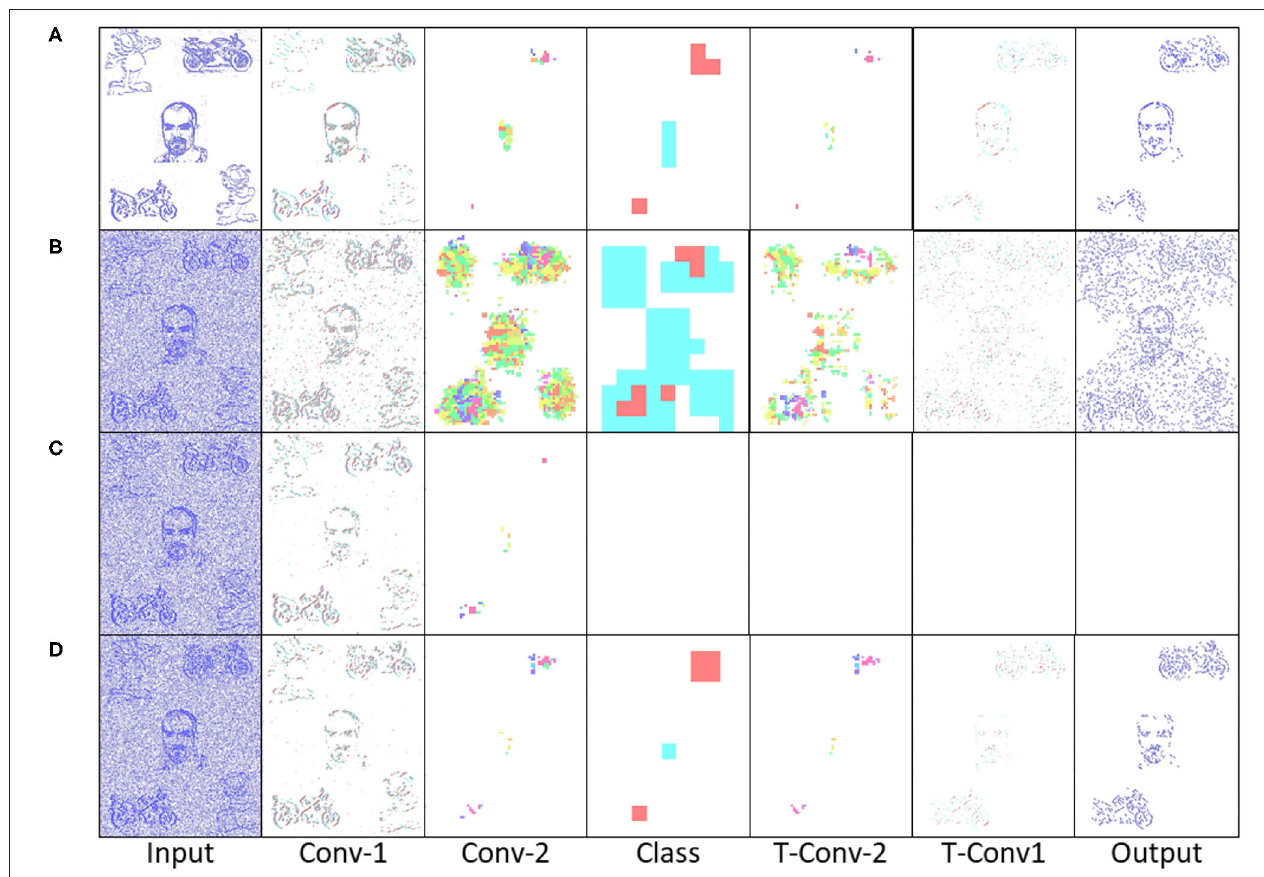
FIGURE 13 | Highlighting the Robust noise suppression with the Pre-Empt then Adapt Thresholding mechanism. (A) Showing no noise input as reference, (B) Showing noisy input without PEAT active, resulting in noisey output, (C) Pre-Emptive Thresholding causing over suppression of neurons resulting in no output, (D) Shows the input to output with PEAT active, suppressing the noise but allowing the useful data to pass